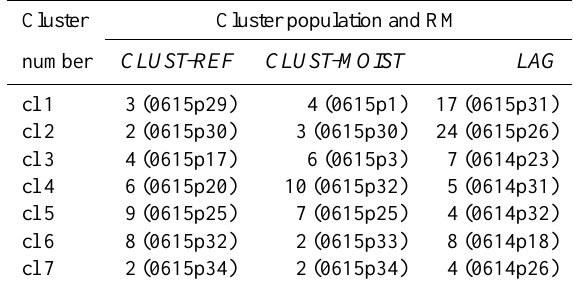
Table 2. Gard case population and RMs for the CLUST-REF , CLUST-MOIST and LAG ensembles: columns 2, 3 and 4, respec- tively. The clustering time is 00:00UTC on 7 September 2010. The RMs (in parenthesis) are expressed as MMDD“p”nn, where nn in- dicates the perturbed element of the ensemble started on day DD. See also text for more